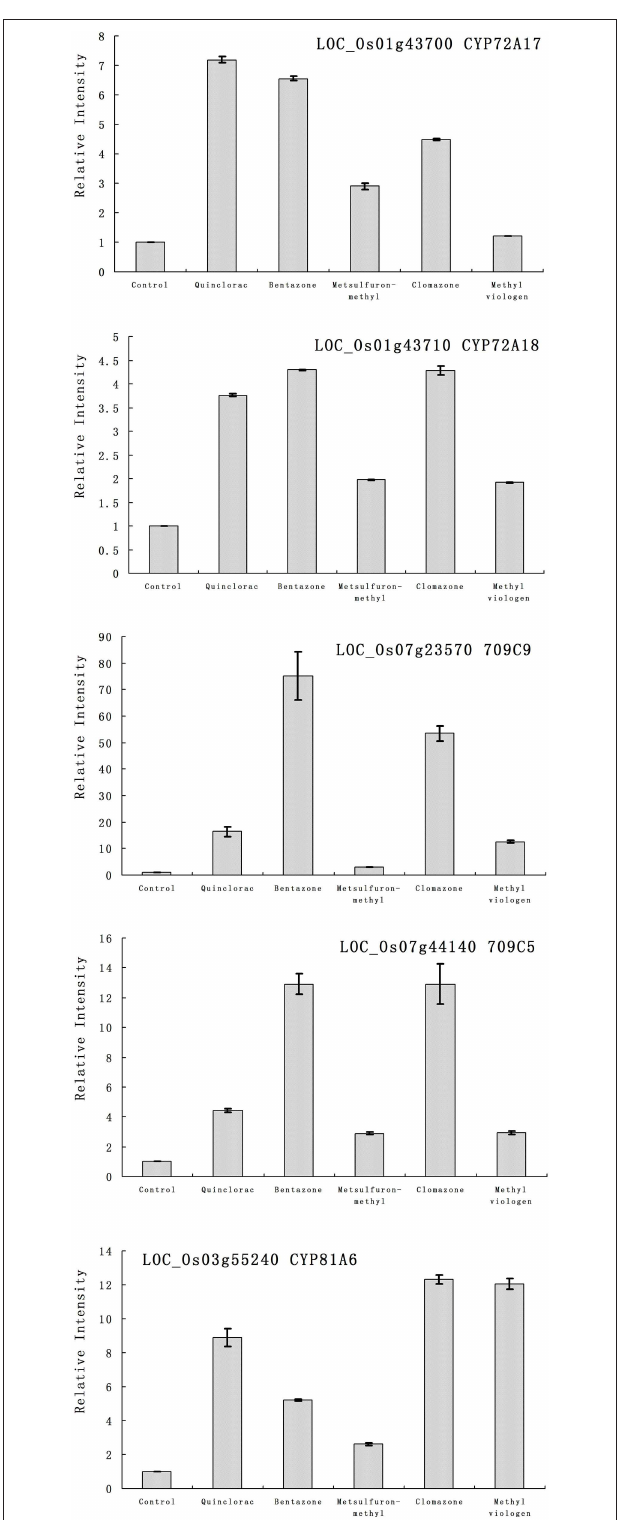
FIGURE 5 | The expression pattern of selected rice cytochrome P450 genes responded to different chemical treatments. The expression